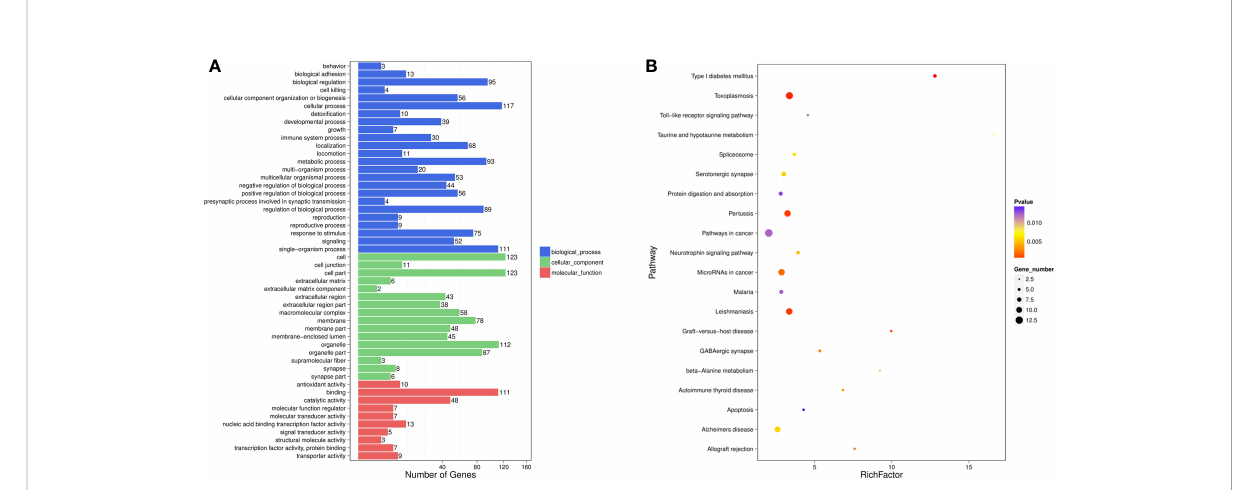
FIGURE 2 GO functional enrichment analysis (A) and KEGG pathway analysis (B) for DE-miRNAs obtained from the comparsion between HBV-non-ACLF and HBV-ACLF groups. Rich actor is the ratio of the DE gene number to the total gene number in a certain pathway. The size and color of the dots represent the gene number and range of the p value, respectively.